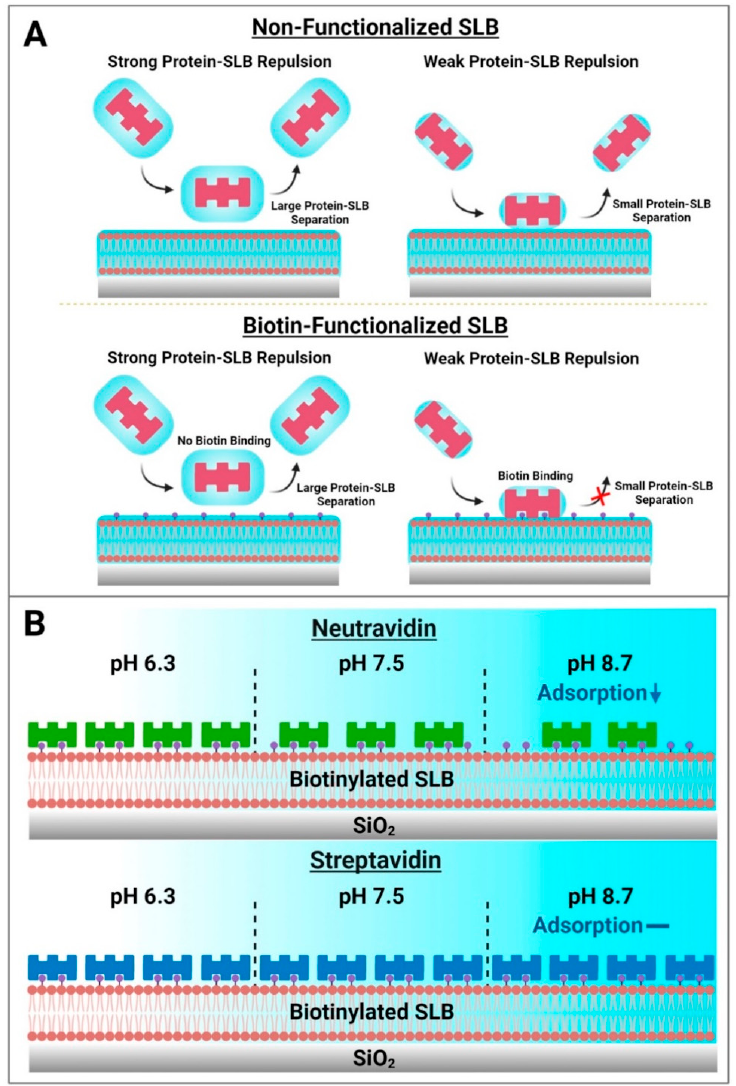
Figure 7. Summary of how biotin-binding proteins attach to biotinylated SLB surfaces and practical implications for biosensing applications. ( A ) Two-step model of how biotin-binding proteins come into contact with lipid bilayer surfaces. Electrostatic interactions modulate the magnitude of the equilibrium separation distance between contacting protein molecules and the SLB surface. In the absence of biotinylated lipid receptors, protein molecules may transiently contact a zwitterionic lipid bilayer but will not adsorb stably and the interaction is fully reversible independent of this separation distance. However, in the case of SLBs containing biotinylated lipid receptors, sufficiently close proximity of a contacting protein molecule to biotinylated lipid receptors (small separation distance) can result in strong binding, resulting in irreversible protein attachment. ( B ) Schematic illustration of Neu and Strep protein adsorption trends for SLB functionalization. Neu adsorption to biotinylated SLBs occurs in a pH-dependent manner, while Strep adsorption occurs in a pH-independent manner that can be useful for reliable surface